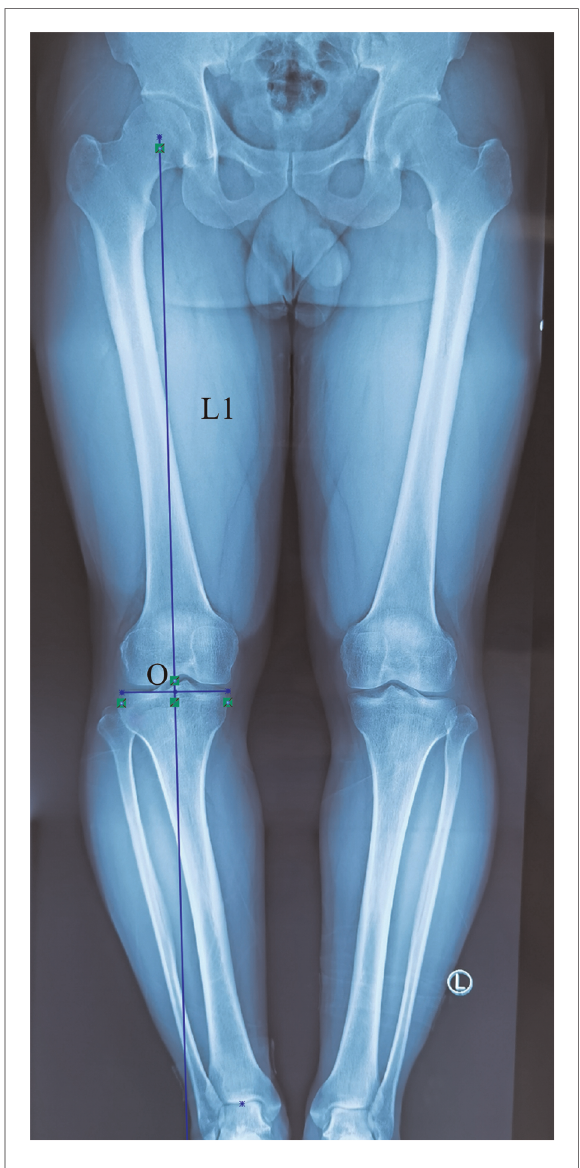
FIGURE 1 The target weight-bearing point (O) was set at 50% of the tibial plateau, and L1 represents the target weight-bearing line.